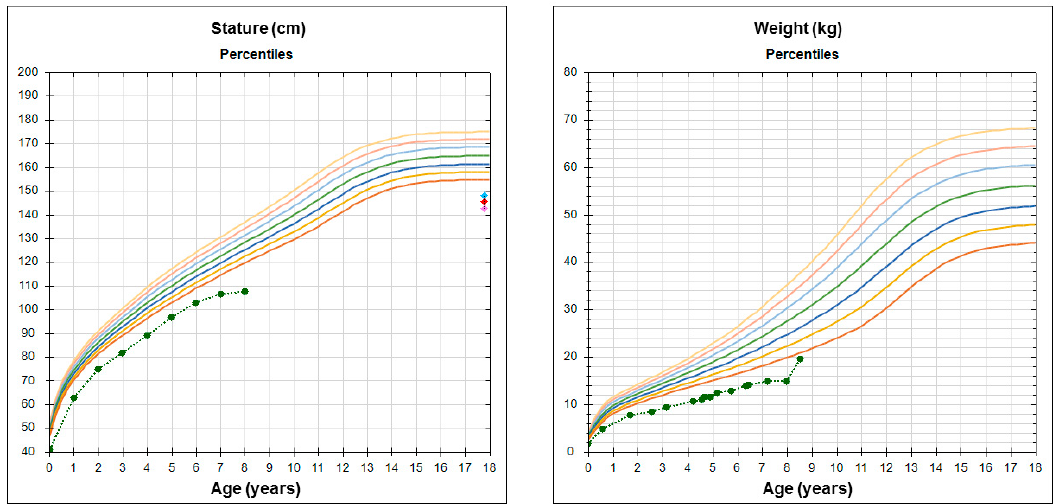
Figure 1. Height and weight charts. Green dots and dashed line represent the patient’s data.